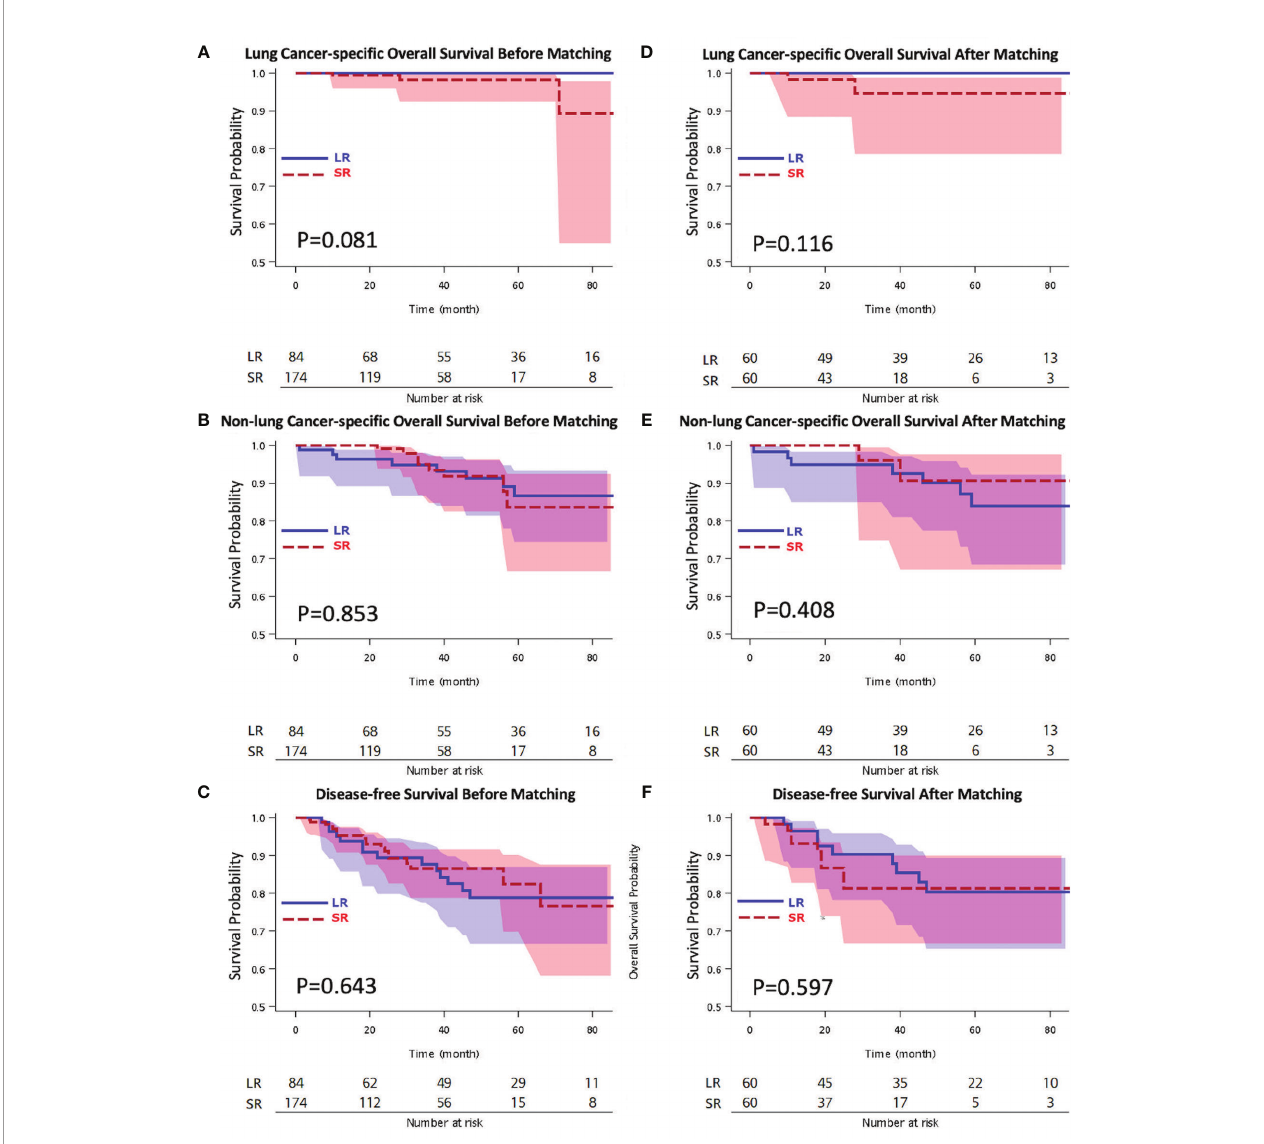
FIGURE 2 | Kaplan-Meier overall survival by (A) lung cancer-speci fi c overall survival survival, (B) non-lung cancer-speci fi c overall survival, (C) disease-free survival analyses before matching, and (D) lung cancer-speci fi c overall survival, (E) non-lung cancer-speci fi c overall survival, (F) disease-free survival analyses after matching. LR, lobectomy; SR, sublobar